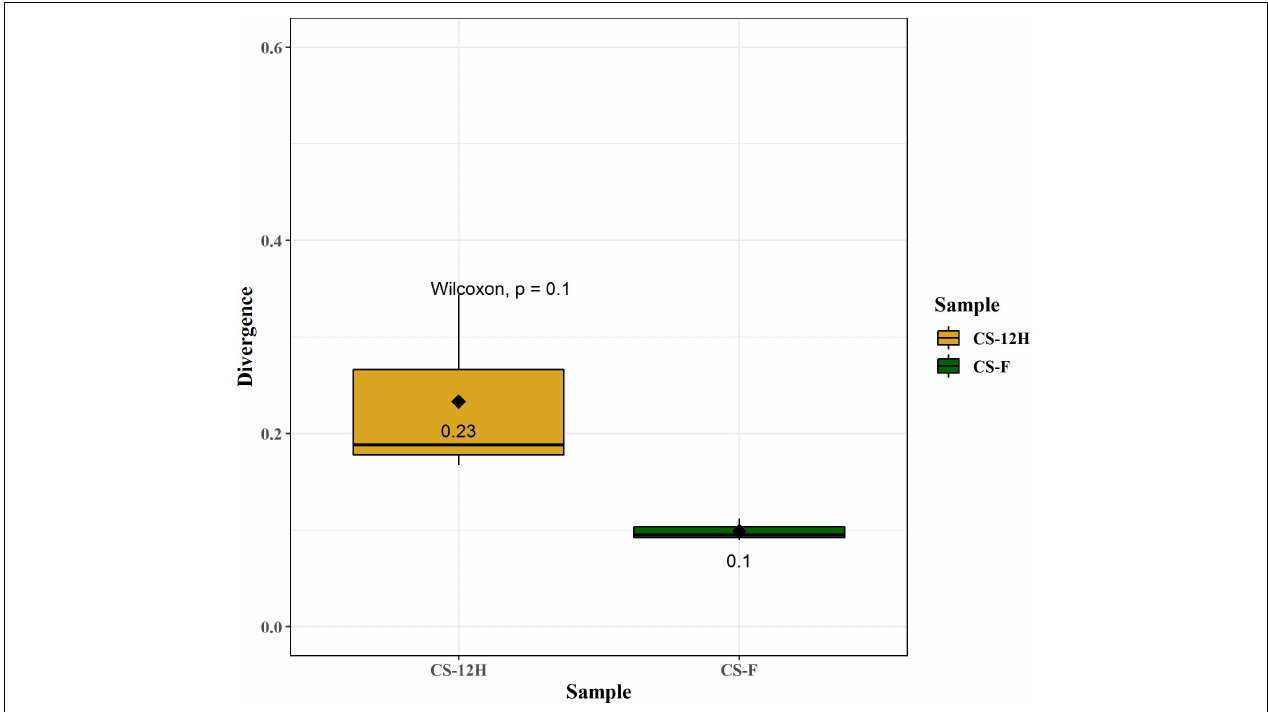
FIGURE 3 | Quantification of bacterial divergence (heterogeneity/spread) within given samples by the mean sample dissimilarity or beta diversity. Taking average, over all pairwise dissimilarities is sensitive to sample size and heavily biased as the similarity values are not independent. To reduce this bias, the dissimilarity of each sample against the group mean is calculated. Here, CS-F sample divergence is 0.1, whereas CS-12H sample divergence is 0.23. These can be compared between groups in order to compare differences in group